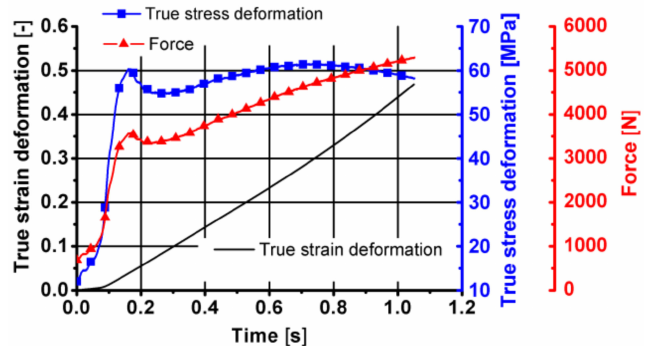
Figure 31. Changes in the true strain deformation, true stress deformation and force over time in the second stage of the friction welding of the 6XXX series